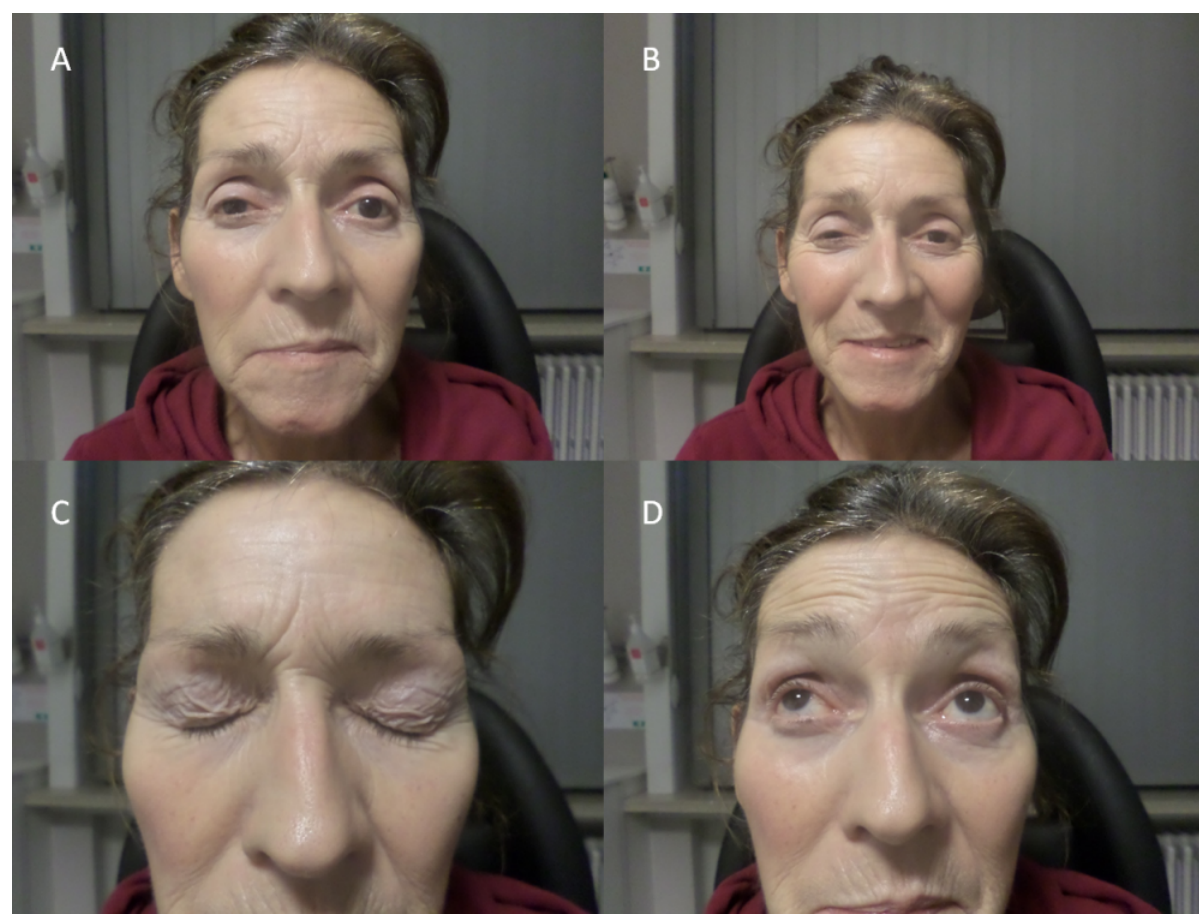
Figure 1: Right-sided central facial palsy of the lower part of the face. Note the drooping of the right mouth (A and B) with preserved eyelid closure (C) and upper facial muscle function when pulling up the eyebrows (D). Also note the right-sided Horner syndrome with mild ptosis and miosis